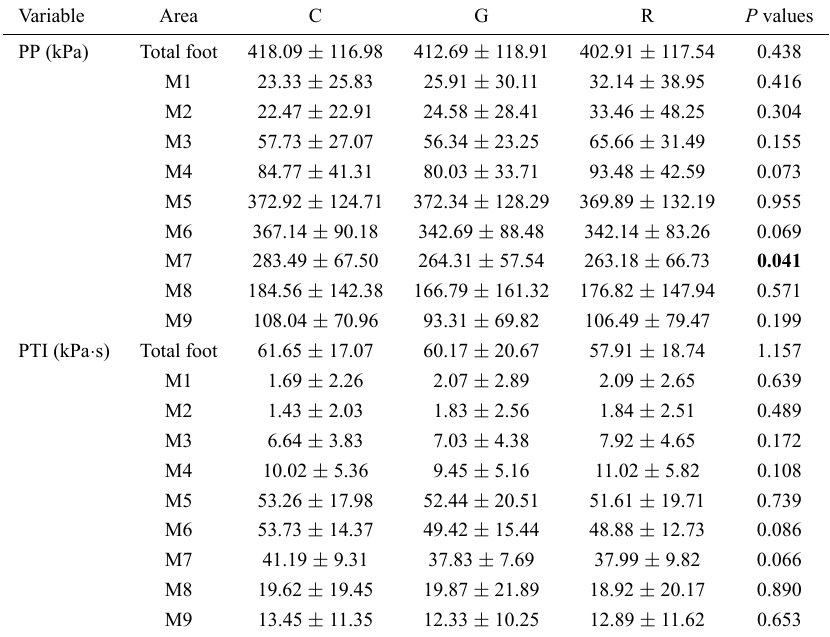
Table 1. Comparison of PP and PTI for running on different surfaces. Variable